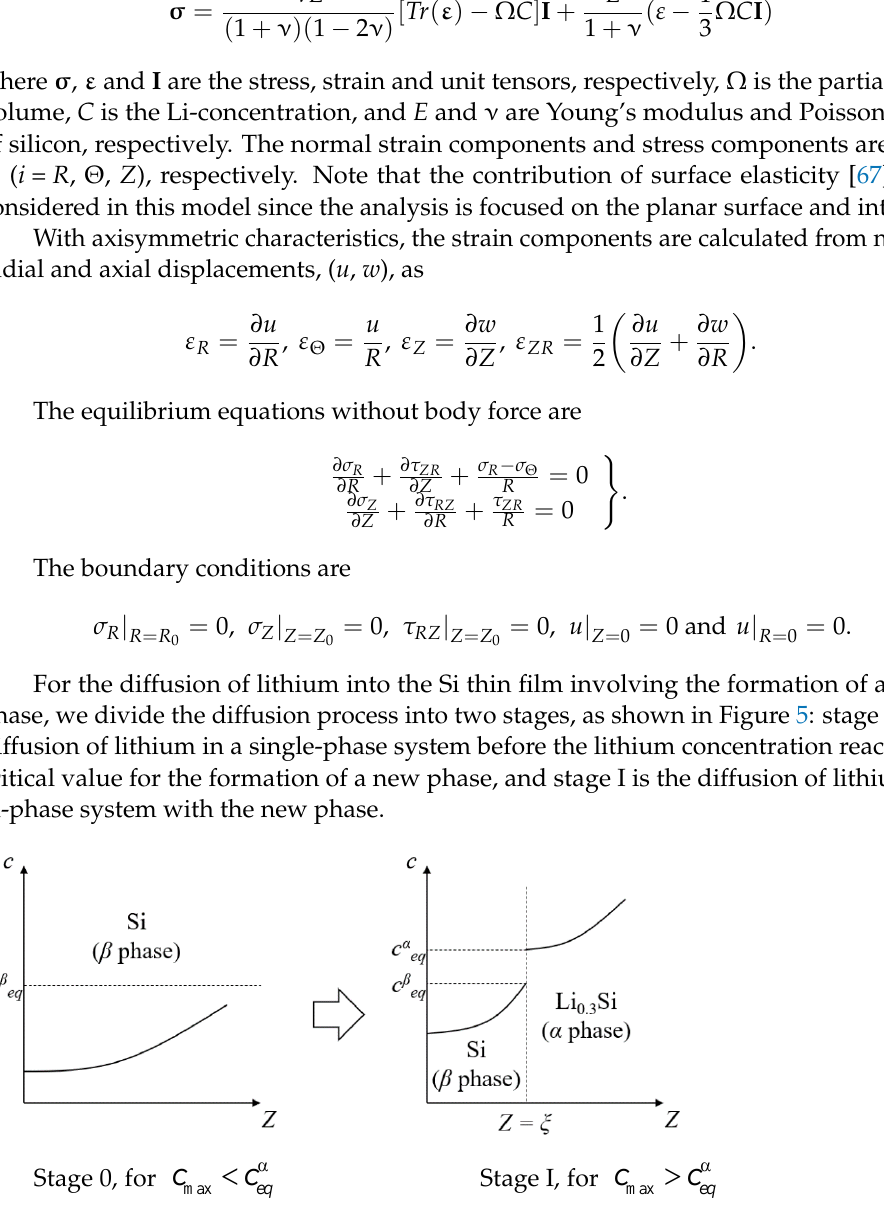
Figure 5. Schematic of the Li concentration distribution at two different stages during the lithiation of the Si thin film.